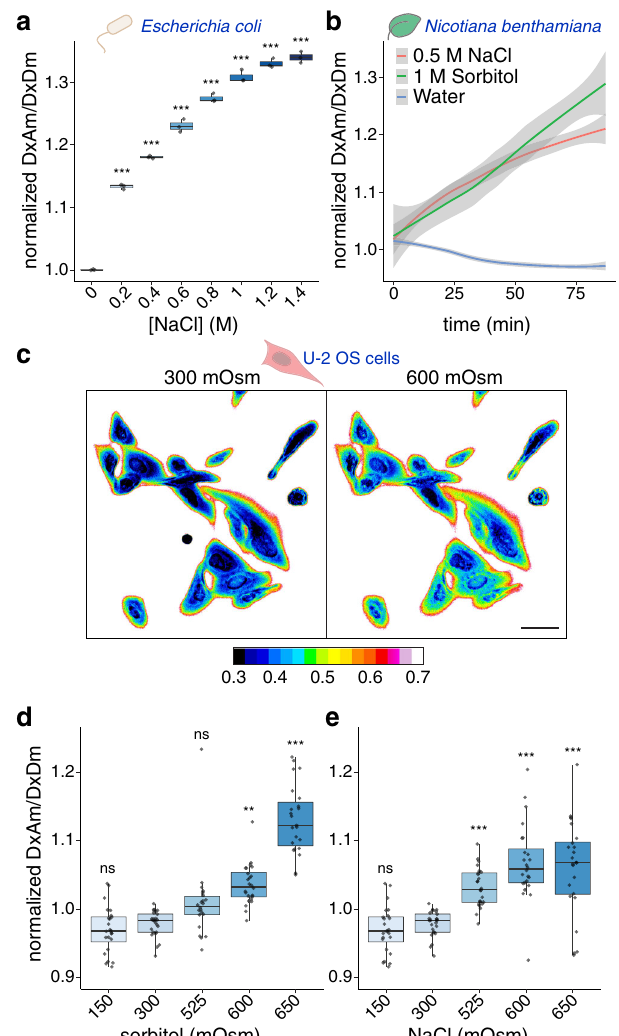
Fig. 5 SED1 tracks changes in osmolarity of a wide set of organisms. a Normalized FRET ratio (DxAm/DxDm) of live SED1-expressing Escherichia coli cells treated with different concentrations of NaCl. n = 3 independent experiments. One-way ANOVA. * p < 0.05, ** p < 0.01, *** p < 0.001. Boxes represent 25th – 75th percentile (line at median) with whiskers at 1.5*IQR. b Normalized FRET ratio (DxAm/DxDm) time course of Nicotiana benthamiana leaf discs transiently expressing SED1, treated with either water, 0.5 M NaCl, or 1 M sorbitol. n = 7 – 11 leaf discs. Mean ± SEM. One-way ANOVA. c Ratiometric image of live SED1-expressing U-2 OS cells at 300 mOsm (isosmotic) or 600 mOsm (hyperosmotic) treated with sorbitol. Scale bar = 50 μ m. Calibration bar represents the normalized FRET ratio (DxAm/DxDm). d Normalized FRET ratio of SED1-expressing U-2 OS cells exposed to different osmotic treatments with sorbitol. n = 5 cells, 5 regions of interest per cell. One-way ANOVA. * p < 0.05, ** p < 0.01, *** p < 0.001. Boxes represent 25th – 75th percentile (line at median) with whiskers at 1.5*IQR. e Normalized FRET ratio of SED1-expressing U-2 OS cells exposed to different osmotic treatments with NaCl. n = 5 cells, 5 regions of interest per cell. One-way ANOVA. * p < 0.05, ** p < 0.01, *** p < 0.001. Boxes represent 25th – 75th percentile (line at median)